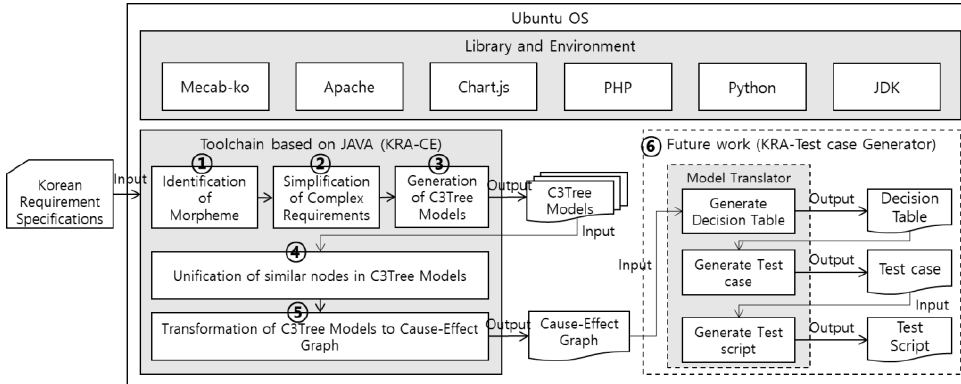
Figure 12. The Environment of KRA-CE.